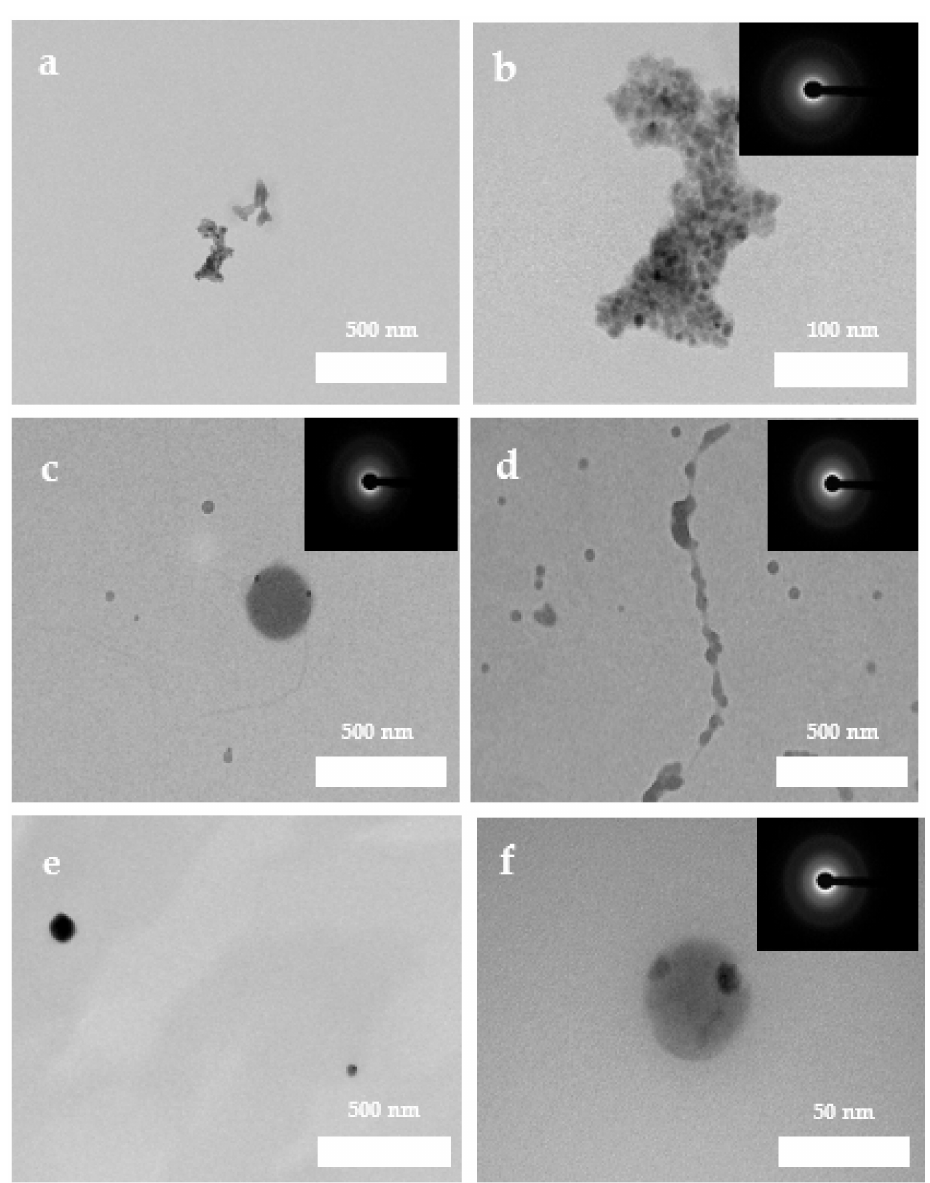
Figure 3. ACO particles obtained during the early stages of nucleation in the absence of PAA. ( a ) TEM images of ACO particles, ( b ) TEM images and SAED pattern of ACO nanoparticles. And in presence of PAA with ( c ) 10 mg/L PAA, ( d ) 50 mg/L, ( e ) 100 mg/L PAA, ( f ) ACO nanoparticle showing different